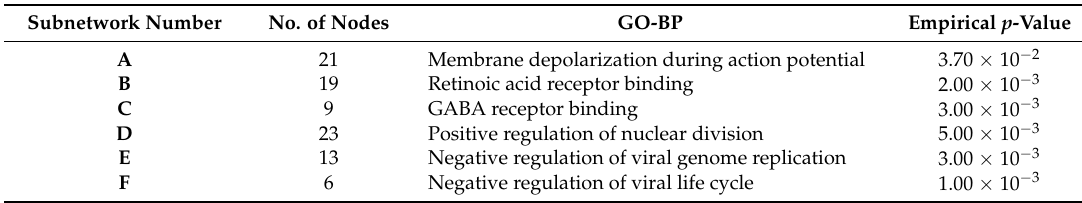
Figure 8. The differentially regulated sub-networks with potential cardiotoxicity disturbed by bufadienolide-like chemicals, generated by the PhenomeScape plug with seeds of 11 cardiotoxicity phenotypes. ( A ) Subnetwork related to membrane depolarization during action potential (3.70 × 10 − 2 ), ( B ) Subnetwork related to retinoic acid receptor binding (2.00 × 10 − 3 ), ( C ) Subnetwork related to GABA receptor binding (3.00 × 10 − 3 ), ( D ) Subnetwork related to positive regulation of nuclear division (5.00 × 10 − 3 ), (E) subnetwork related to negative regulation of viral genome replication (3.00 × 10 − 3 ), and ( F ) subnetwork related to negative regulation of viral life cycle (1.00 × 10 − 3 ). Table 4. Summary of differentially regulated sub-networks with potential cardiotoxicity disturbed by bufadienolide-like